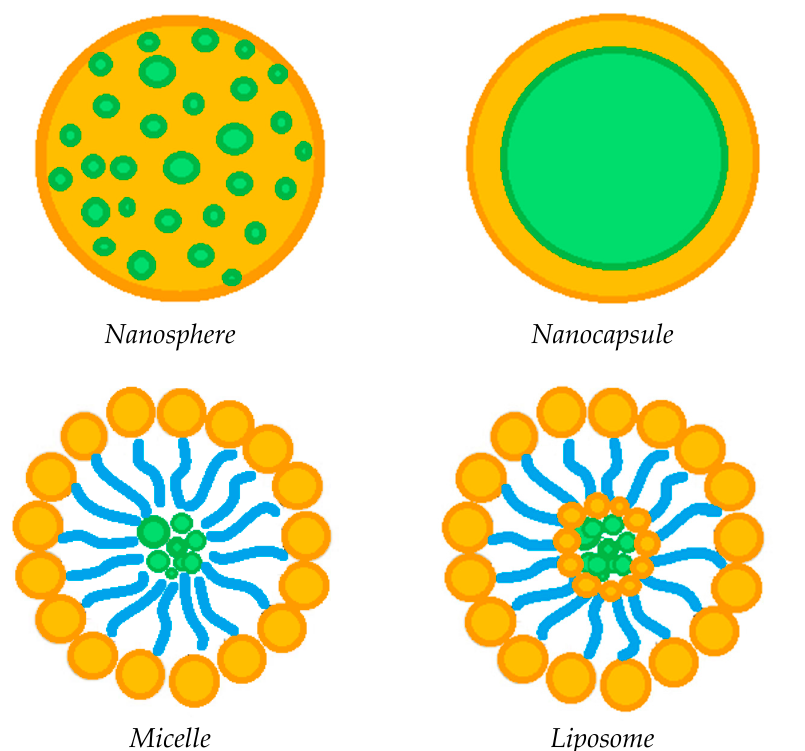
Figure 4. Possible drug-loaded structures incorporated into therapeutic contact lenses.